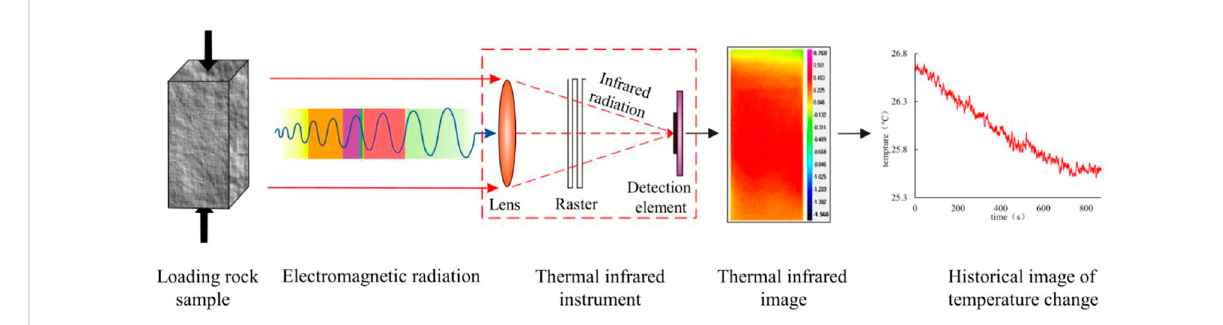
FIGURE 2 Schematic diagram of thermal infrared radiation detection principle (According to Cai, 2020b).